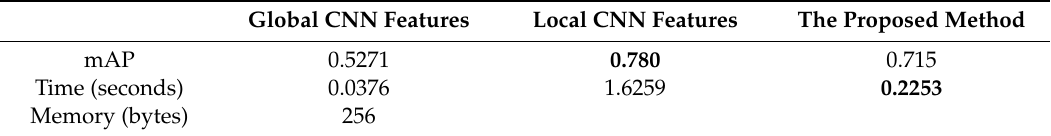
Table 2. Comparison between the proposed method and its two versions on Oxford5k.